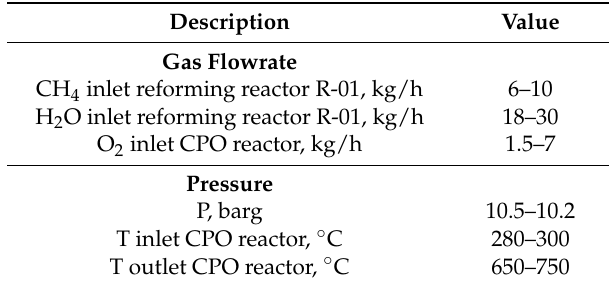
Table 8. Main operating conditions of the membrane-based GTL process.